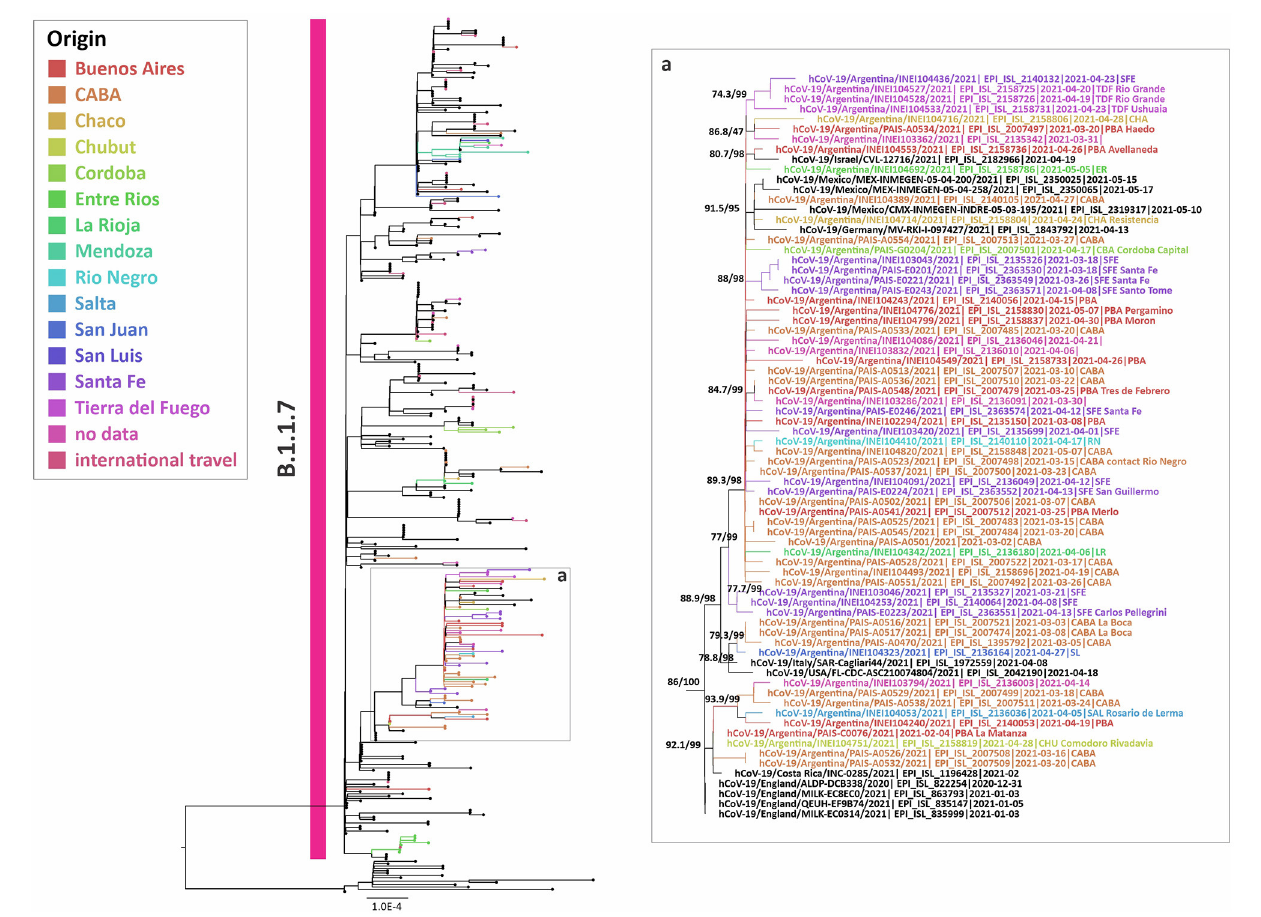
FIGURE 3 | Phylogenetic tree of SARS-CoV-2 whole-genome sequences of Alpha (lineage B.1.1.7). B.1.1.1 sequences were used as outgroup. Only the largest group with Argentinean sequences is shown. The SH-like/UFB values for the relevant groups are indicated for some groups. UFB, ultrafast bootstrap. The right panel (a) represents an inset of the largest B.1.1.7 group from the